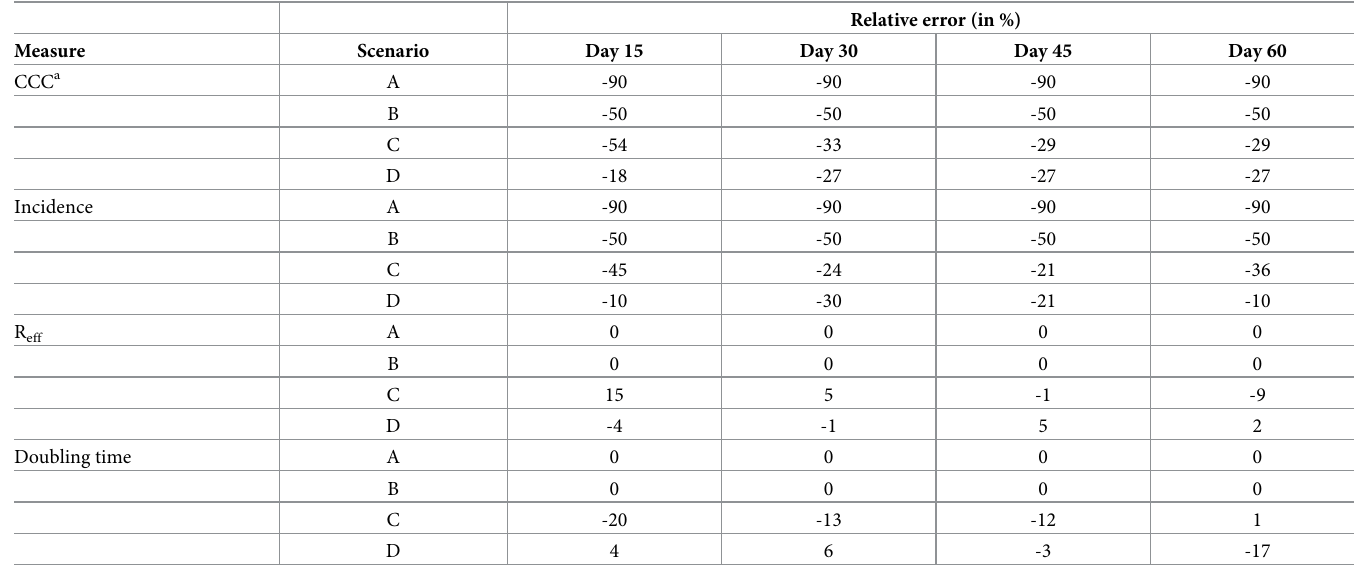
Table 1. Relative errors in the CDR